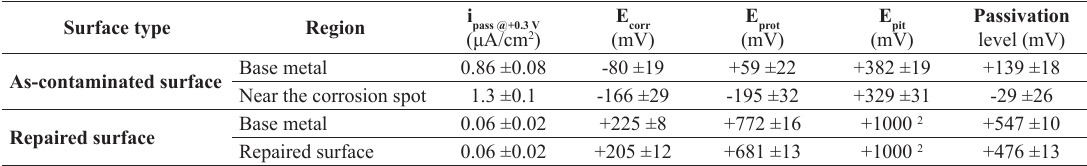
was not registered. This behavior was noted for all repaired surface pit